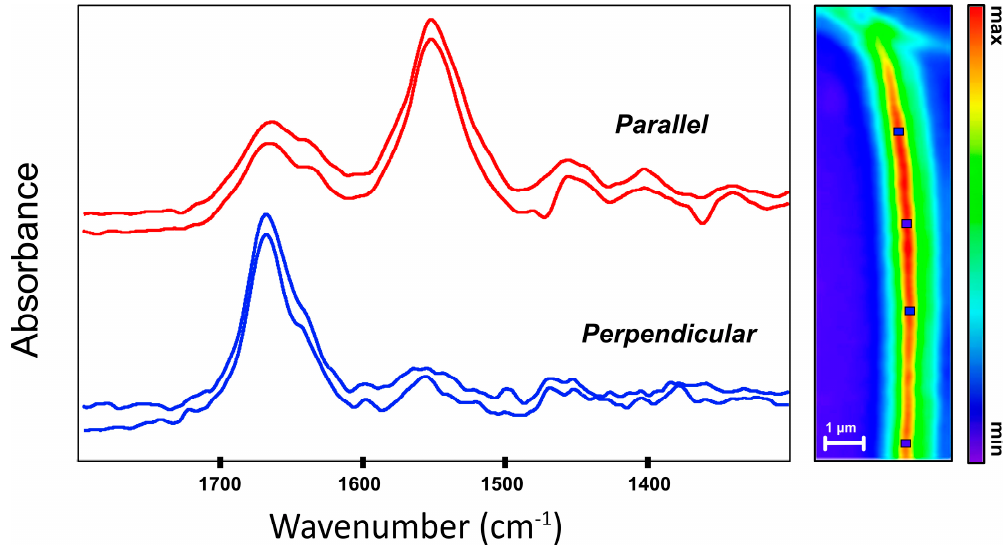
Figure 3. Spectra obtained with O-PTIR from control tendon fibrils on CaF 2 window. Top spectra (red) obtained with fibril parallel to laser polarization; bottom spectra, sample rotated by 90°. Single frequency image at right recorded at 1655 cm − 1 in perpendicular orientation. Squares denote locations at which some of the spectra were acquired. Scale bar = 1 μ m.